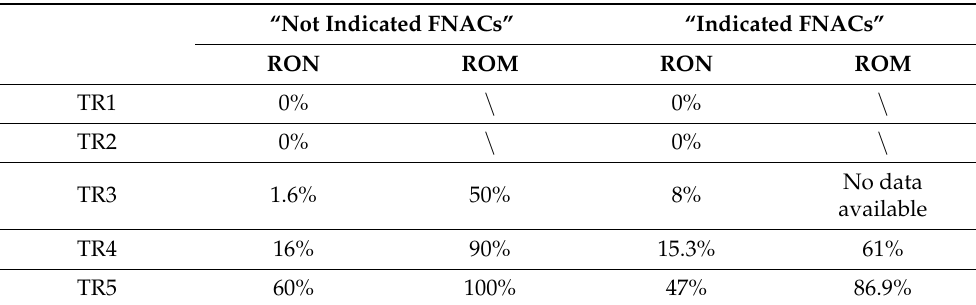
Table 4. Analysis of RON and ROM for each ACR TI-RADS category in “not indicated” vs “indicated” FNACs groups. “Not Indicated FNACs” “Indicated